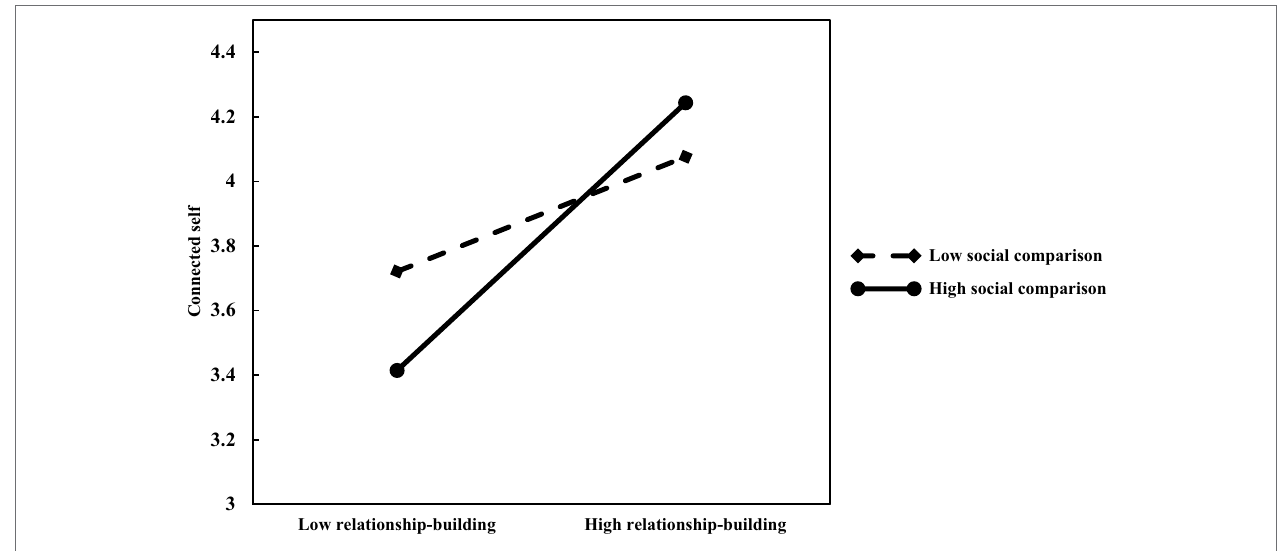
FIGURE 2 | The moderating effect of social comparison on the relationship between relationship building and connected self.